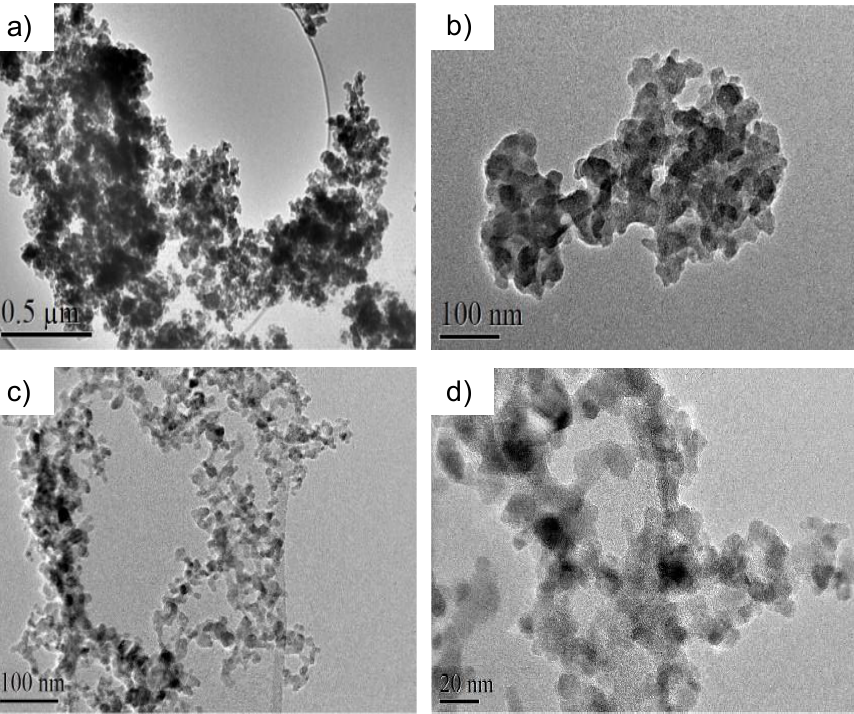
Figure 2. TEM images at different magnifications for SiO 2 , ( a , b ), and Al 2 O 3 nanoparticles, ( c , d ).